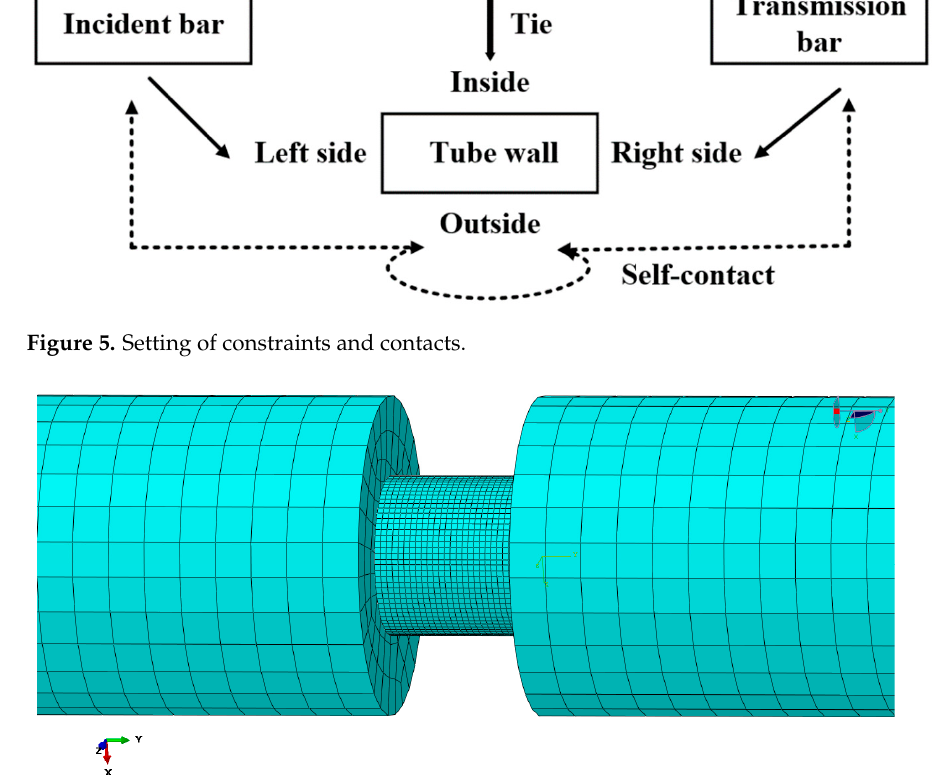
Figure 6. Mesh generation of assembly.